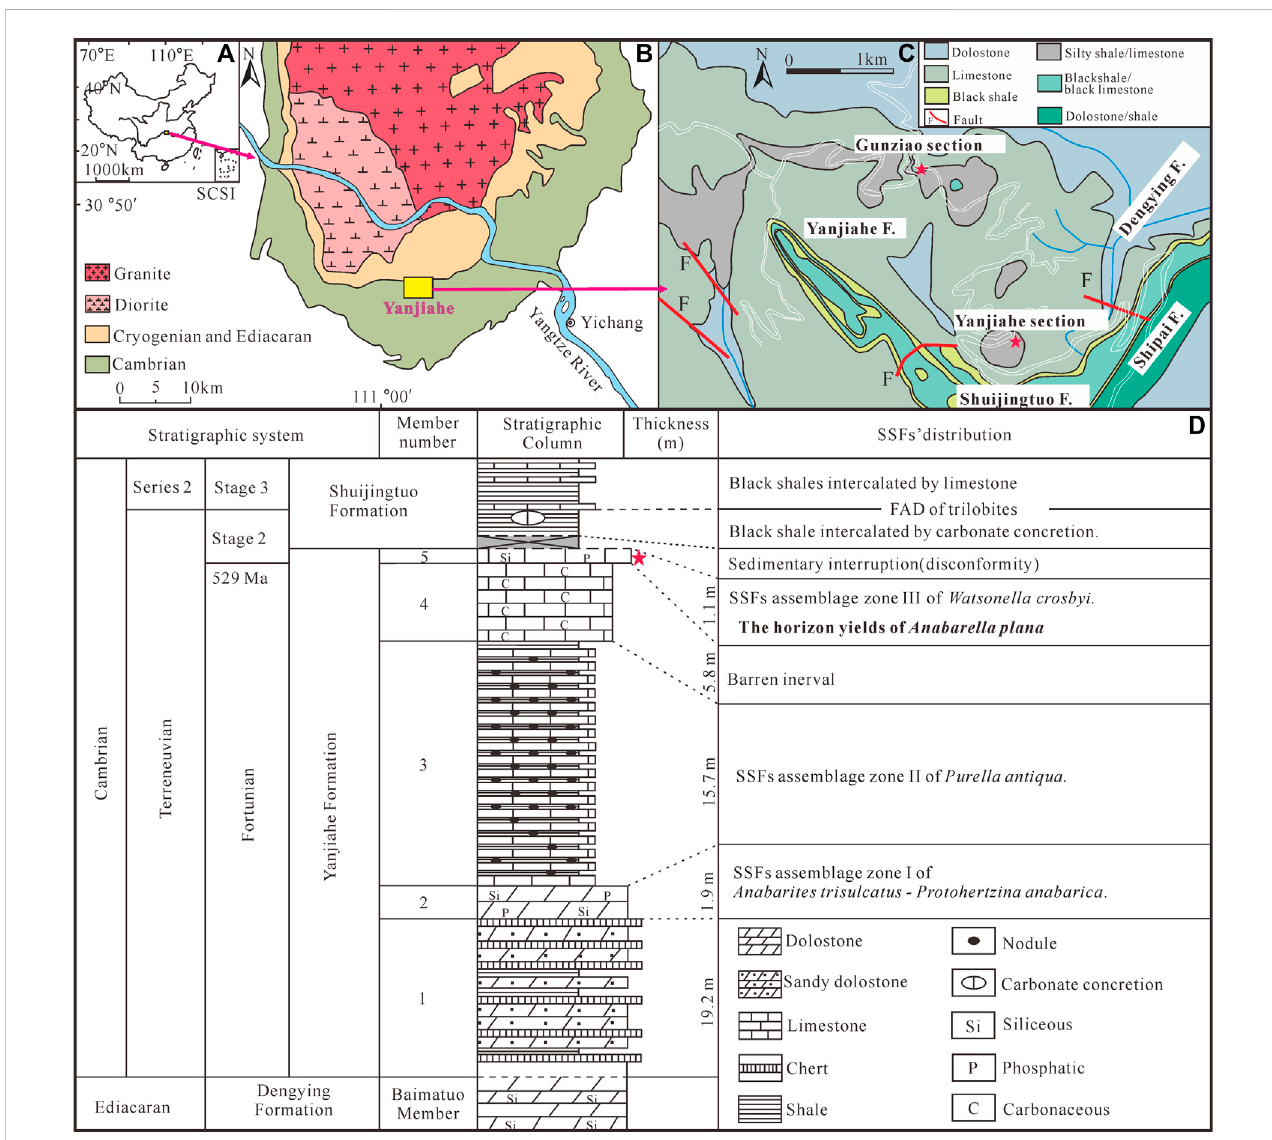
FIGURE 1 Location and stratigraphy of the Terreneuvian Yanjiahe Formation in the Three Gorges area, Hubei Province, China (modi fi ed from Guo et al., 2021). (A) Sketch map of the People ’ s Republic of China, the rose-red arrow showing the position of the collecting locality in Hubei Province. (B) Simpli fi ed geological mapoftheThreeGorgesarea,HubeiProvince,showingtheoutcropsoftheCambrianstrata,therose-redarrowshowingthepositionoftheYanjiahearea. (C) Detailed geological map of the Yanjiahe area, showing the outcrops of the Yanjiahe Formation, red stars showing the locations of the Yanjiahe Section and Gunziao Section. (D) Lithostratigraphic column and biostratigraphy of key SSFs from the Yanjiahe Formation in the Yanjiahe section, Three Gorges area, red star indicating the horizon where specimens of A. plana were